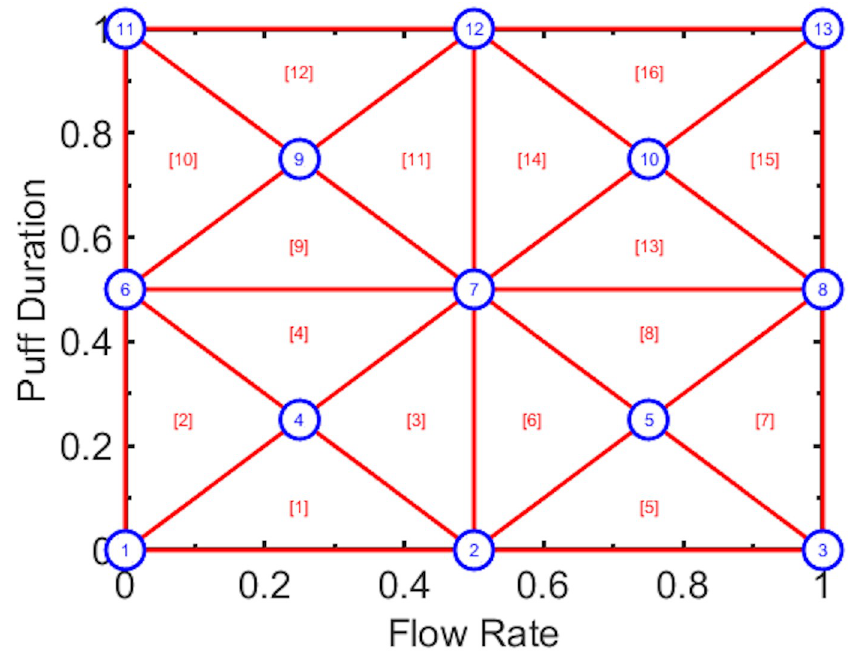
Fig 1. Prototypical emission topography protocol composed of 13 flow conditions (pattern 1-3-5-3-1). The horizontal and vertical axes represent the marginal cumulative distribution functions of natural environment observed puff flow rate and duration,